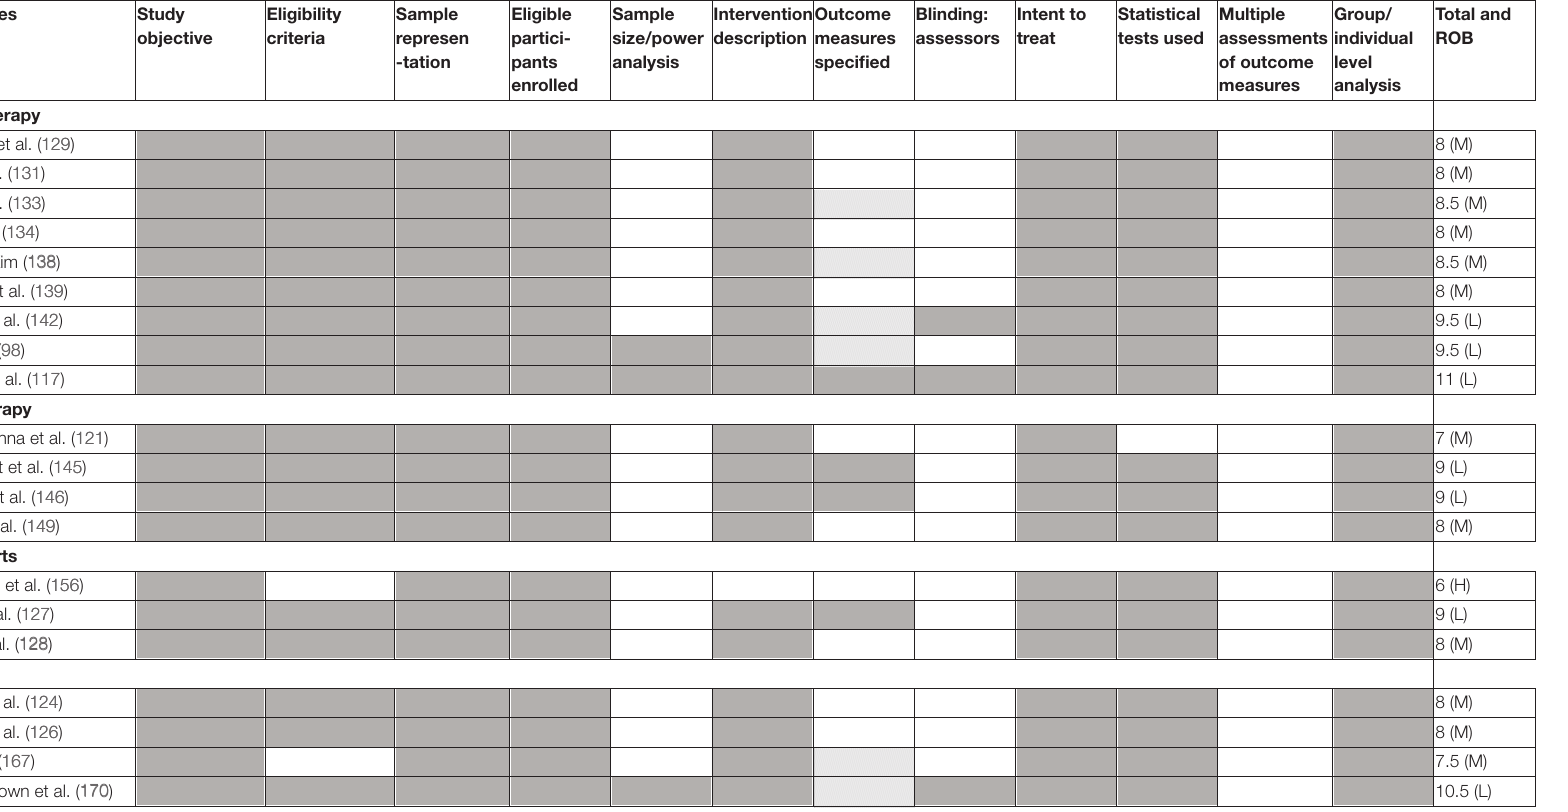
Gray shaded cells indicate that the criterion has been fully satisfied (receives a score of 1 point for that item), cells with diagonal stripes indicate that the criterion was partially satisfied (receives a score of 0.5) and blank cells indicate that the criterion has not been satisfied (receives a score of 0 points for that item). Total scores are calculated by summing the number of gray shaded cells (except criterion 1) for each individual study. ROB, Risk of bias; H, High risk of bias; M, Moderate risk of bias; L, Low risk of bias. Risk of bias rating based on scoring on ratings on NIH quality assessment tool for pre-post designs (i.e., Low risk = scores ≥ 9, High risk = scores ≤ 6, Moderate risk = scores of